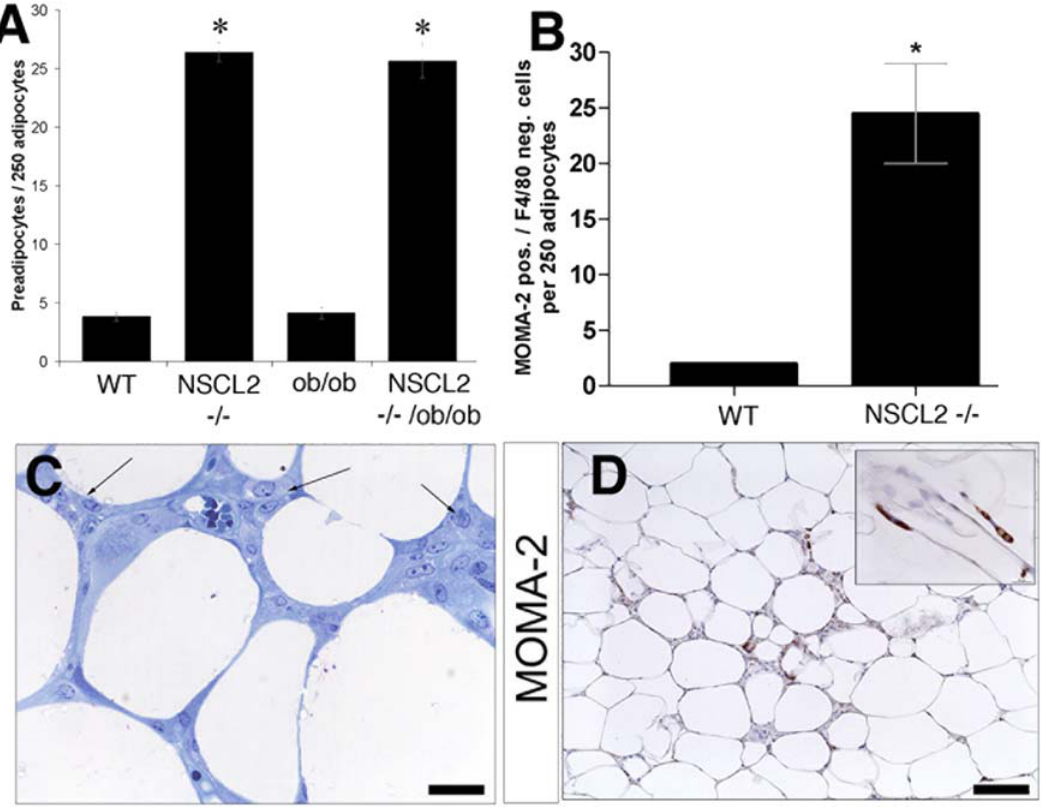
Figure 5. High number of preadipocyte/macrophage-like cells in the adipose tissue of Nscl-2 ( 2 / 2 ) and Nscl-2 ( 2 / 2 ) 6 ob/ob compound mutant mice. (A) Number of preadipocyte/macrophage-like cells per 250 adipocytes (F=250.71; dF=3; p , 10 2 4 ; 4 mice per group). (B) Number of MOMA-2 positive but F4/80 negative cells per 250 adipocytes. The difference between MOMA-2 and F4/80 positive cells corresponds to adipocyte precursors (p=0.038). (C) Richardson-stain of a section of epididymal adipose tissue from 6 months old male double mutant mouse. Arrow indicates groups of preadipocyte/macrophage-like cells between fat cells (scale bar: 25 m m). (D) MOMA-2 staining of paraffin embedded epididymal adipose tissue of a Nscl-2 ( 2 / 2 ) mouse (scale bar: 100 m m). The inlet shows a typical staining of MOMA-2 (scale bar: 15 m m).